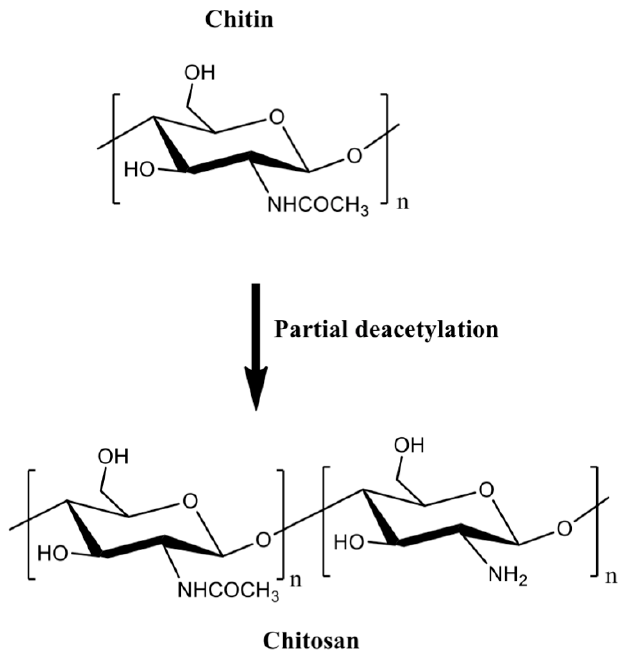
Figure 2. The partial chitin deacetylation produces chitosans with deacetylation degrees higher than 50%.